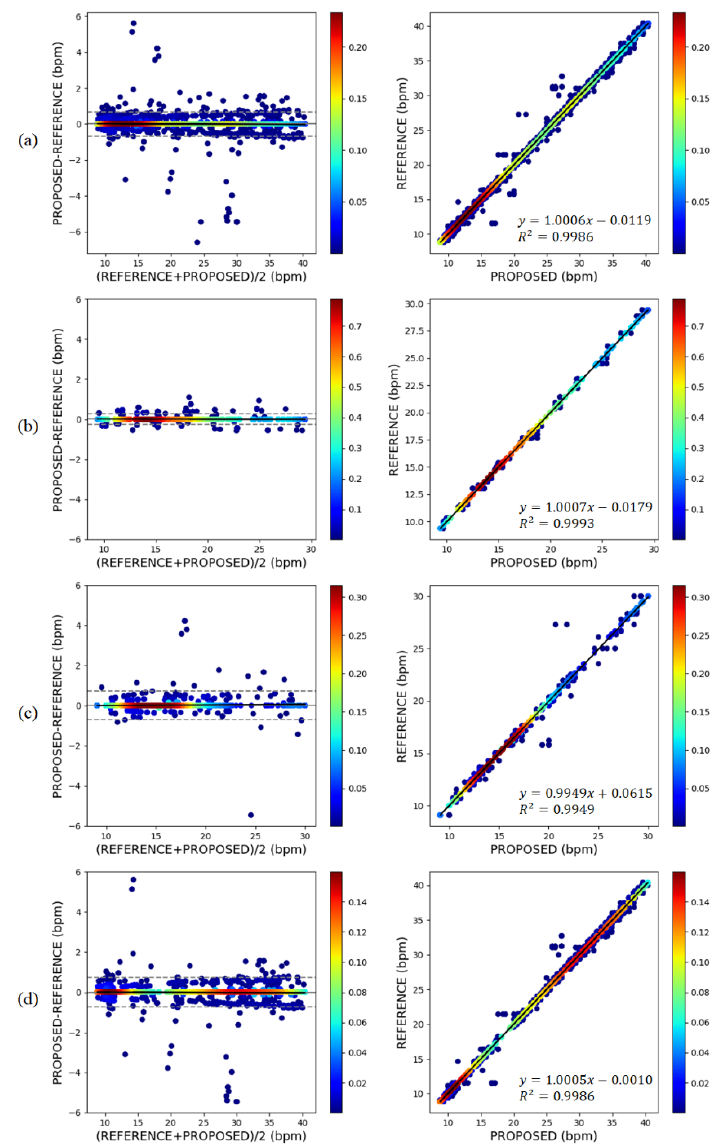
Figure 9. Bland–Altman plot and regression analysis results for bpm: ( a ) overall data; ( b ) Experiment 1; ( c ) Experiment 2; ( d ) Experiment 3.